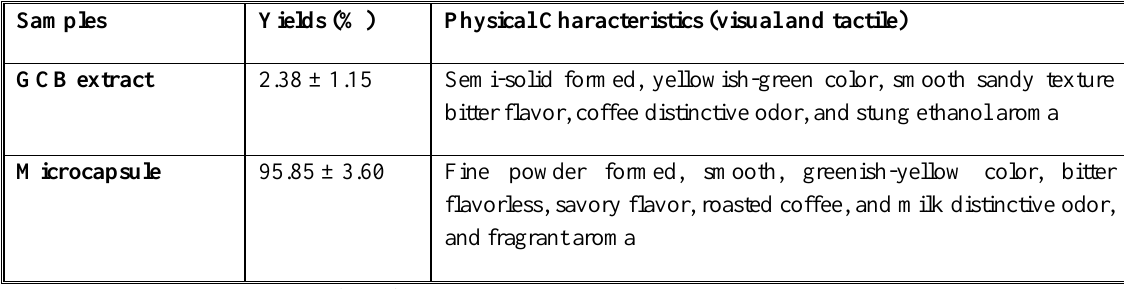
Table 1. The yield and physical characteristics of the GCB extract obtained from the extraction, and the microcapsule product . Yields (%) Physical Characteristics (visual and